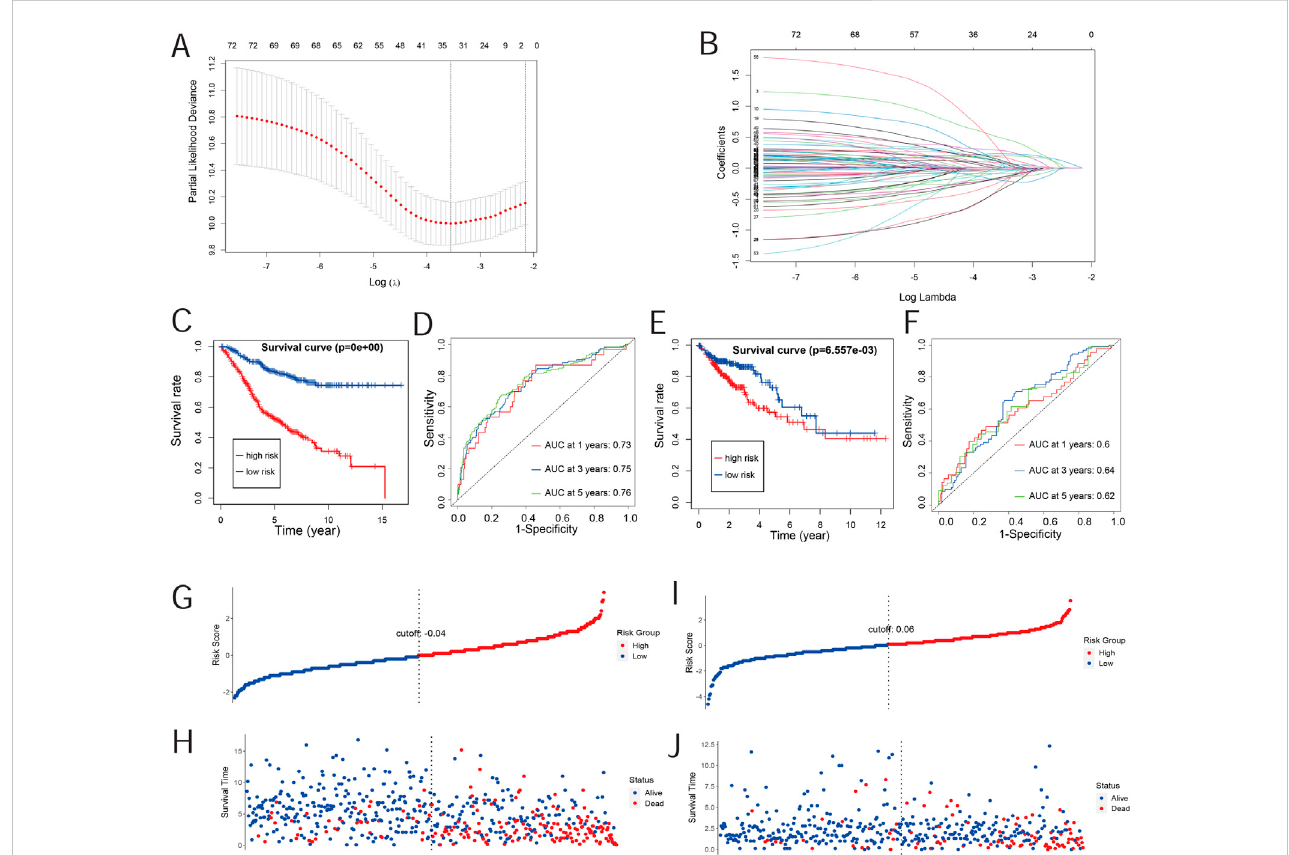
FIGURE 1 Risk-scoring model construction and validation. (A) Illustration for the LASSO coef fi cient spectrum of prognostic genes. (B) Adjusted parameters of the LASSOregressionmodel. (C) Kaplan – MeiercurveanalysisofOSinhigh-riskandlow-riskgroupsbasedontheGEOdatabase. (D) Kaplan – Meiercurveanalysis of OS in high-risk and low-risk groups based on the TCGA database. (E) ROC curve of risk scores in the GEO database. (F) ROC curve of risk scores in TCGA database. (G,H) OverviewofthesurvivaltimeanddistributionofriskscoresoftheGEOdatabase. (I,J) Overviewofthesurvivaltimeanddistributionofrisk scores of TCGA